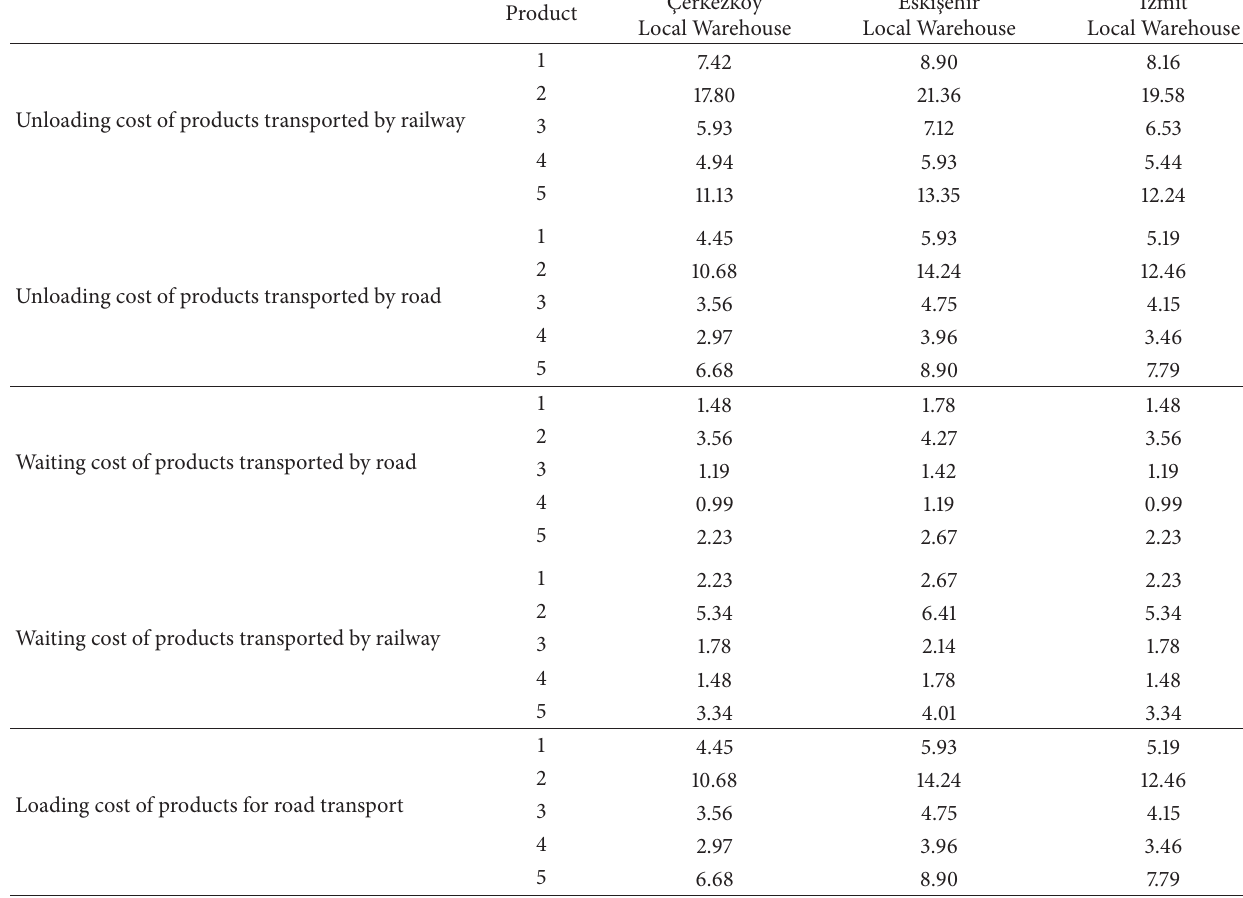
Table 14: Product based unloading, warehousing, and loading costs in local warehouses (TL/product).